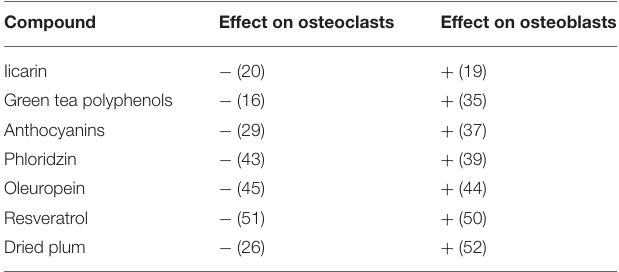
TABLE 1 | Effect of different polyphenols on osteoclasts and osteoblasts activity in vitro . Compound Effect on osteoclasts Effect on osteoblasts